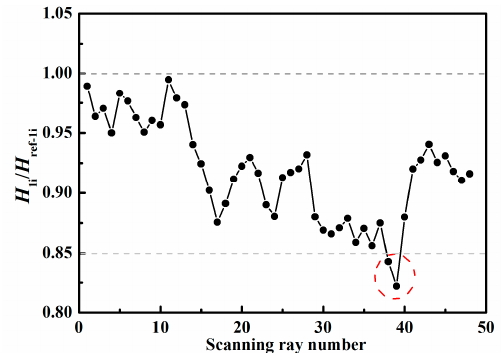
Figure 8. Determination of threshold values for ray paths to bottom-left corner.